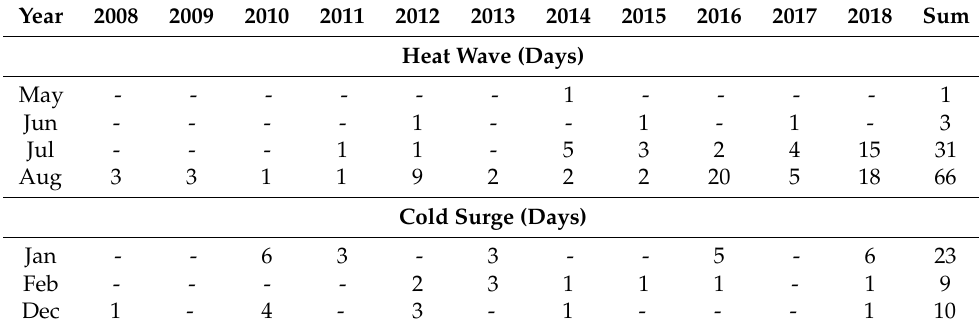
Table 1. Occurrences of heat waves and cold surges in Seoul, Korea